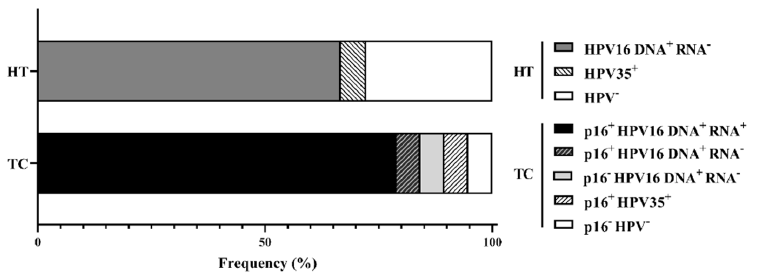
Figure 1. HPV-status of TC and contralateral HT according to p16, HPV E7 DNA, and RNA detection. Tonsillar cancer (TC); healthy tonsil (HT). p16-status (at the time of diagnosis), HPV16 DNA (detection of HPV E7 DNA in fresh biopsies), HPV16 RNA (detection of E7 mRNA normalized over GAPDH levels in fresh